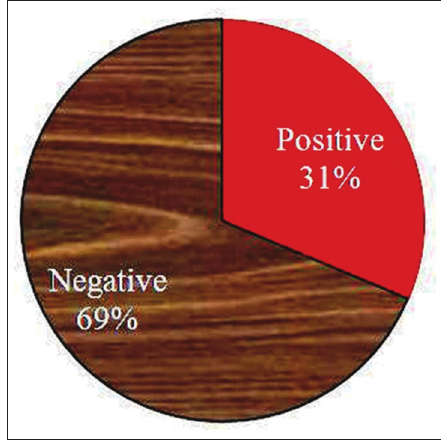
Figure-3: Percent distribution of Fasciola gigantica sero- positive/negative bovines.